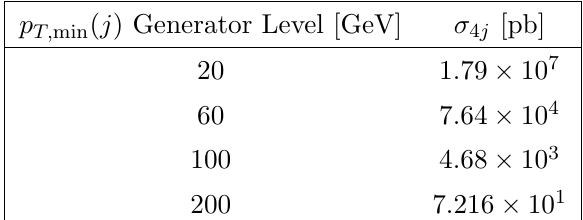
Table 5. Four partonic hard jets production cross section using MadGraph5 at various minimum parton level